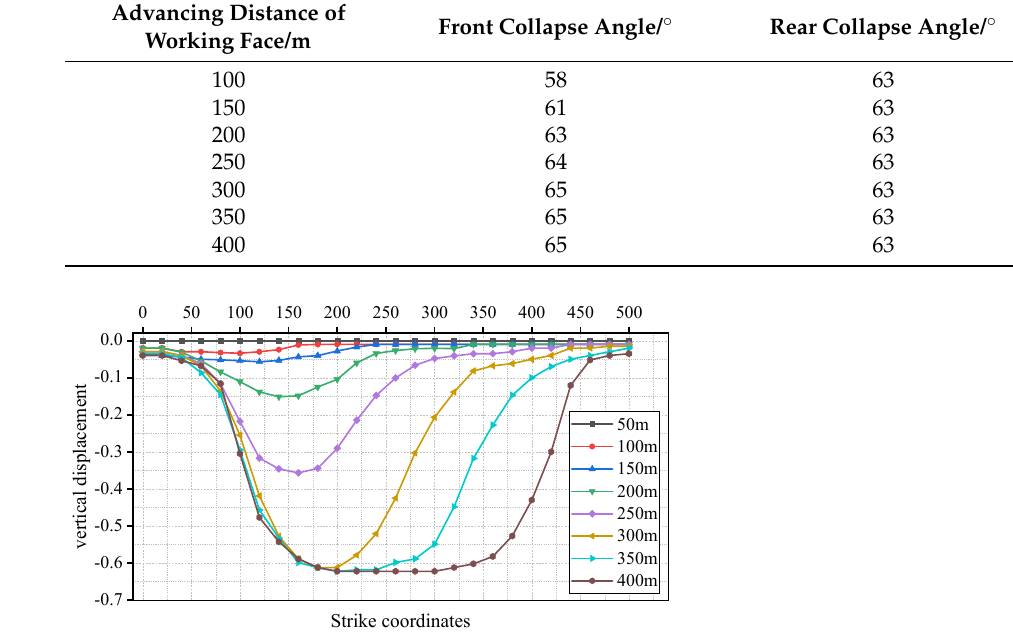
Table 2. Summary of overlying strata caving angles with different advance distances.